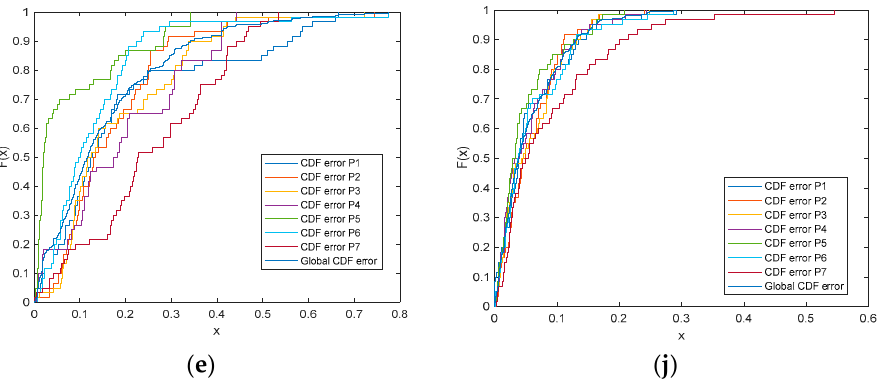
Figure 13. Experimental results for the tested points P1–P7 for both heights, z 1 = 1.35 m on the left ( a – e ) and z 2 = 1.93 m on the right ( f – j ): successively, 3D representation of clouds of points; Y–X projections; Z–X projections; Z–Y projections; and experimental CDFs for each point after AKF fusion. Table 11. Mean errors and standard deviations of estimated positions when applying the AKF at z 1 = 1.35 m and z 2 = 1.93 m for the test points (P1–P7).